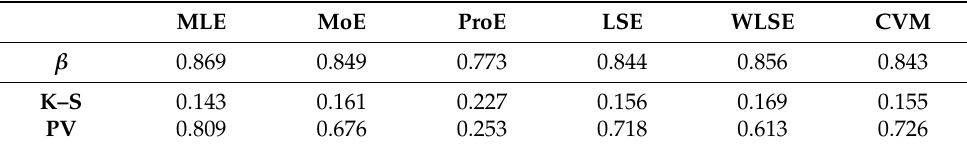
Figure 19. The empirical CDFs plots for data set IV. Table 16 lists different estimators for data set IV; it was found that the MLE, MoE, ProE, LSE, WLSE and CVME methods worked quite well for modeling data set IV, but the MLE approach was the best. Table 16. CVE for data set IV.